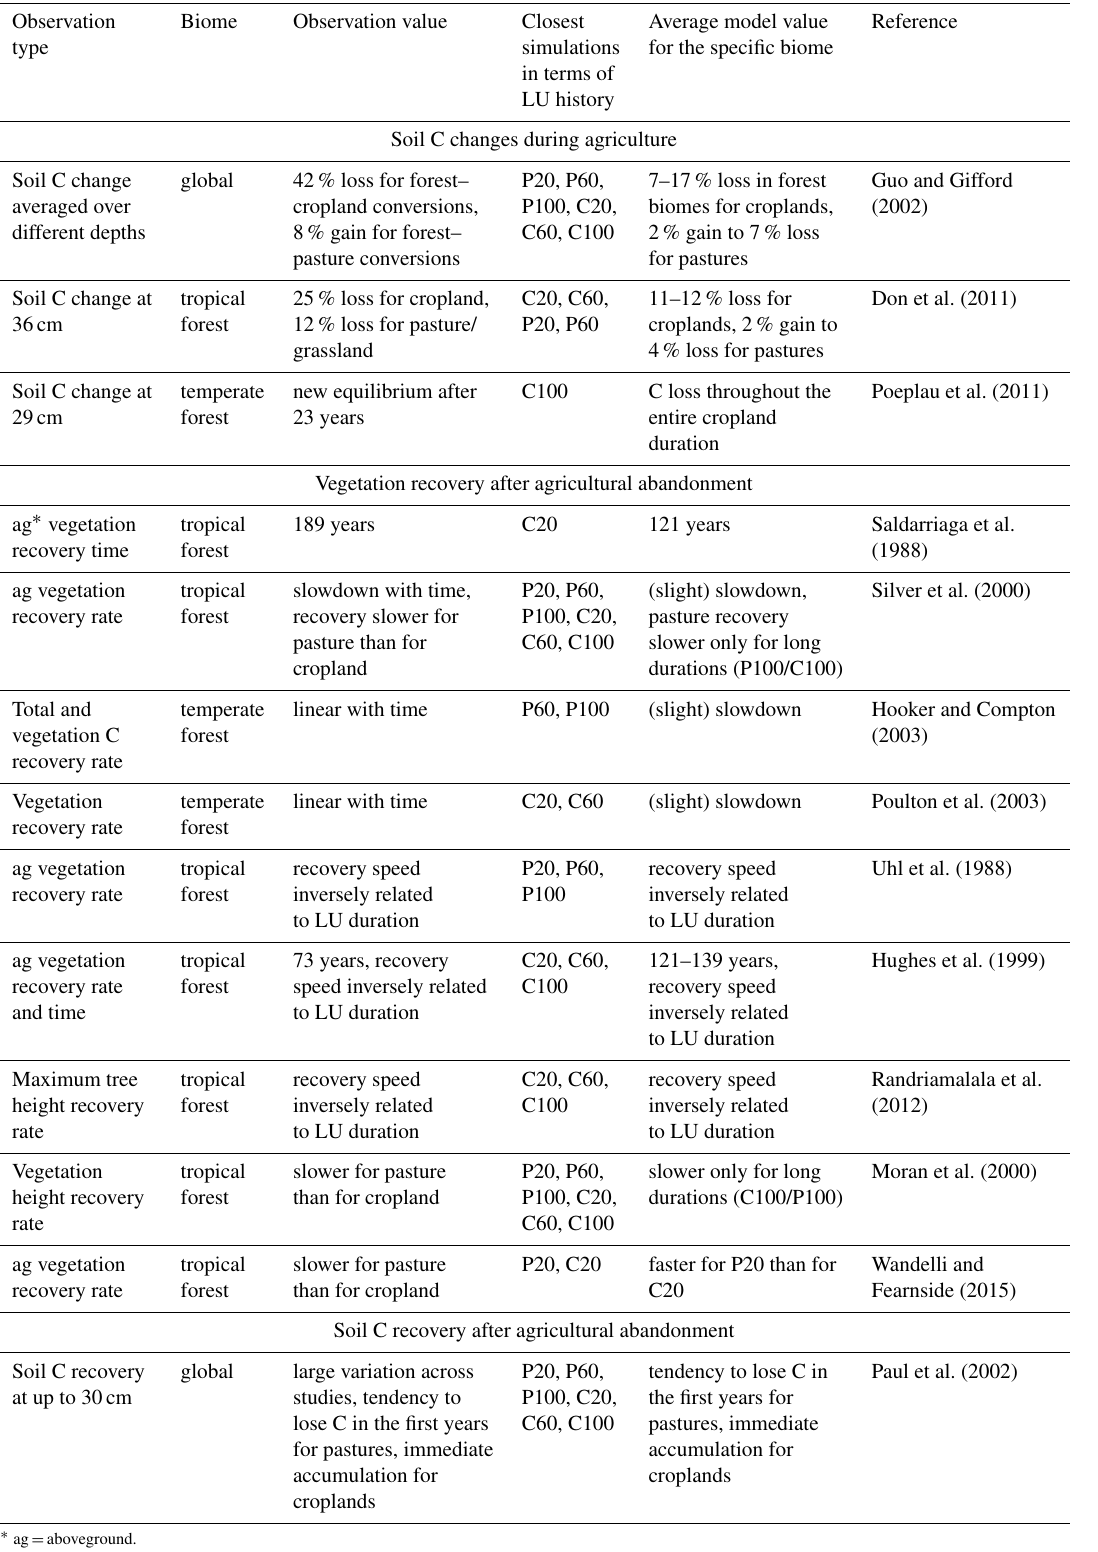
Table 2. Observations and LPJ-GUESS results of soil C changes during agriculture (cropland and/or pasture) and vegetation and soil C recovery after